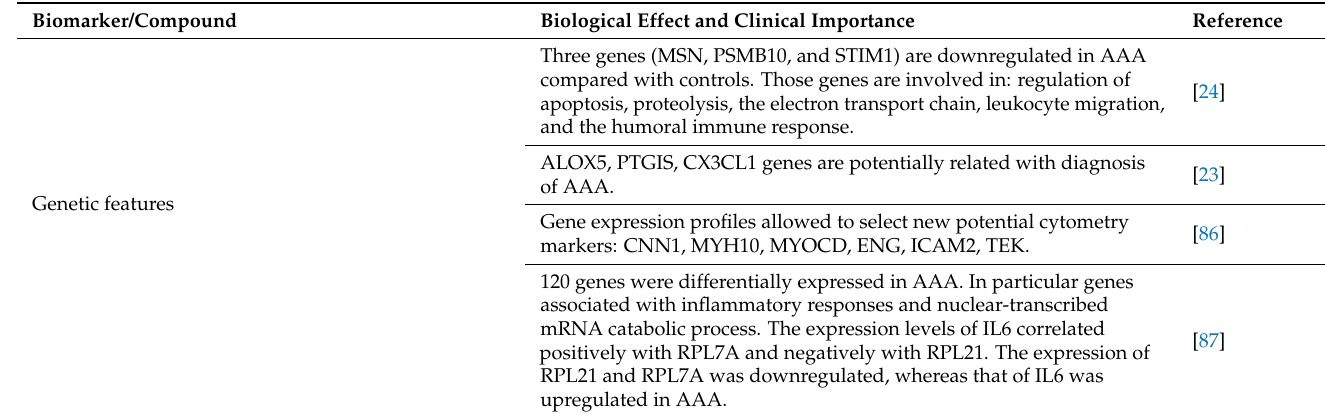
Table 3. Biomarkers and compounds in thoracoabdominal aortic aneurysms (untreated